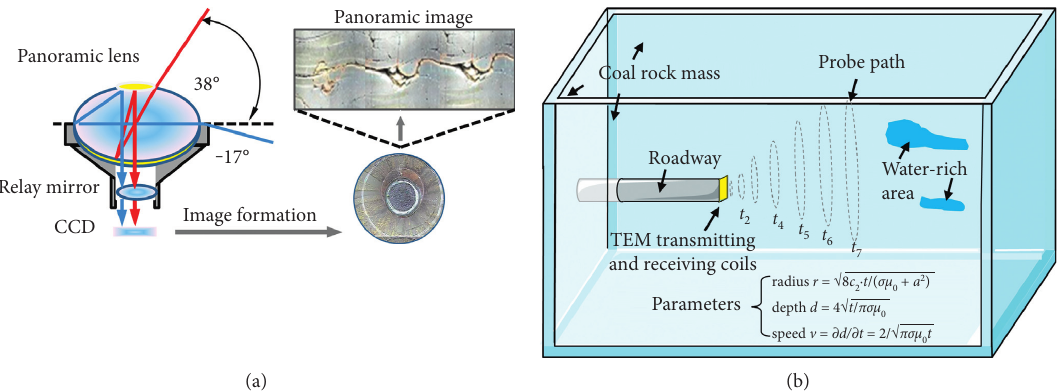
Figure 4: Principle of BT-TEM detection equipment: (a) borehole television principle; (b) mine transient electromagnetic detection